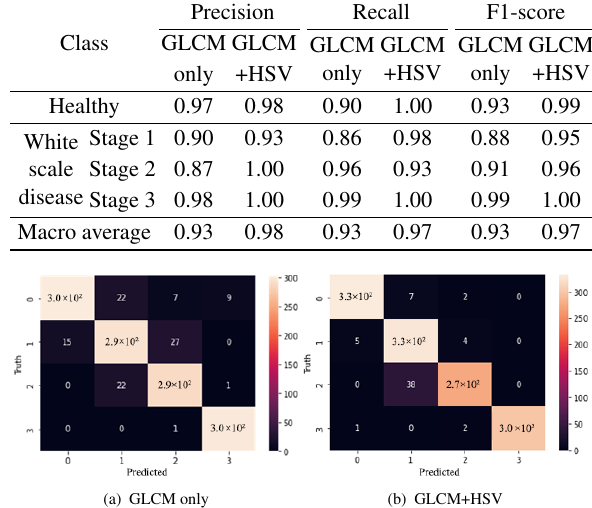
Table 3 Performance comparison of KNN classification on GLCM only and GLCM+HSV features.